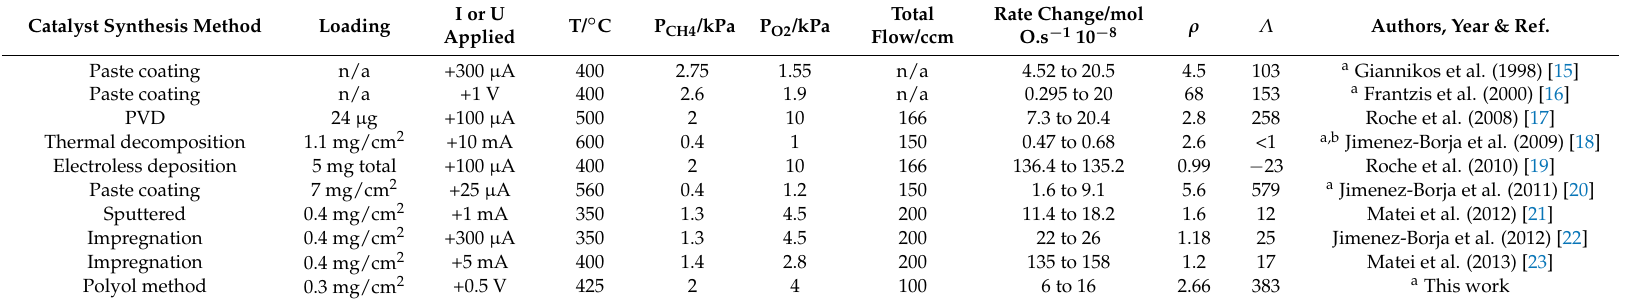
Table 1. Summary of EPOC tests performed for methane oxidation on Pd-YSZ